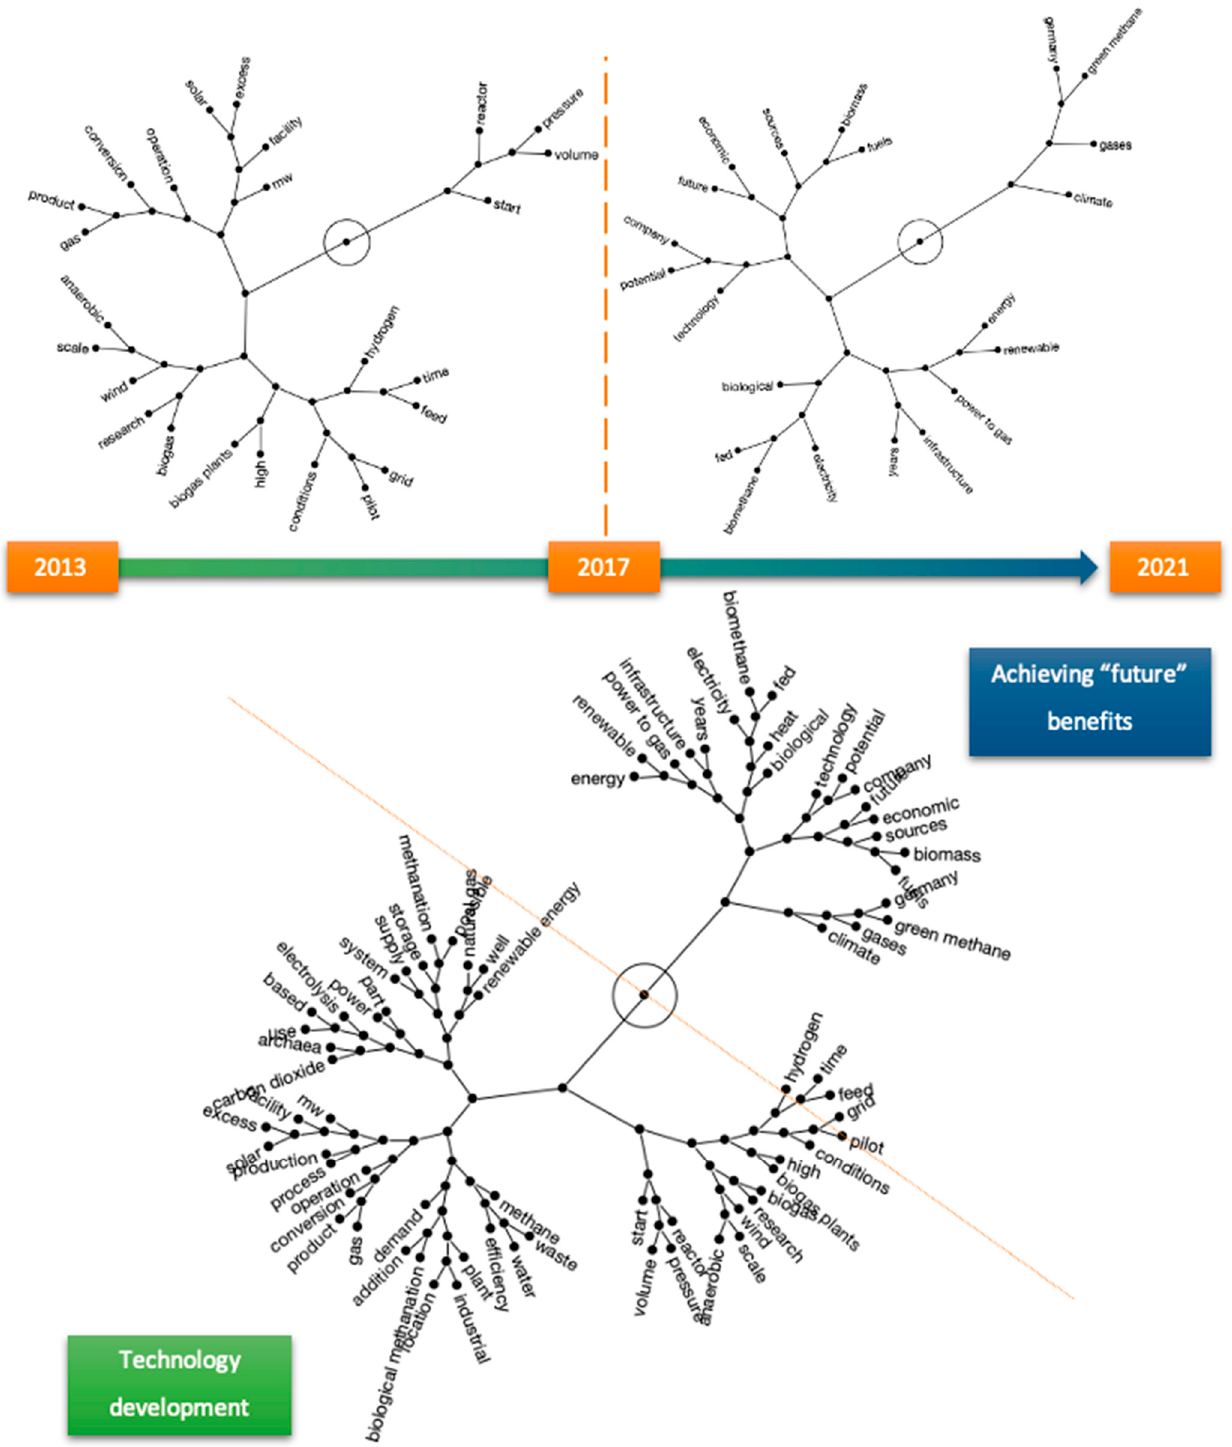
Figure 5. Constellation plots showing clusters of terms according to the project